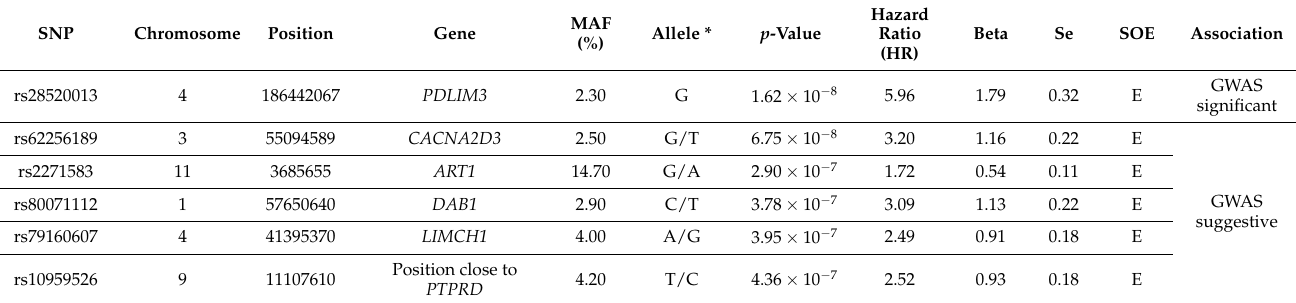
Table 3. GWAS significantly or suggestively associated SNPs with OS from the meta-analysis.